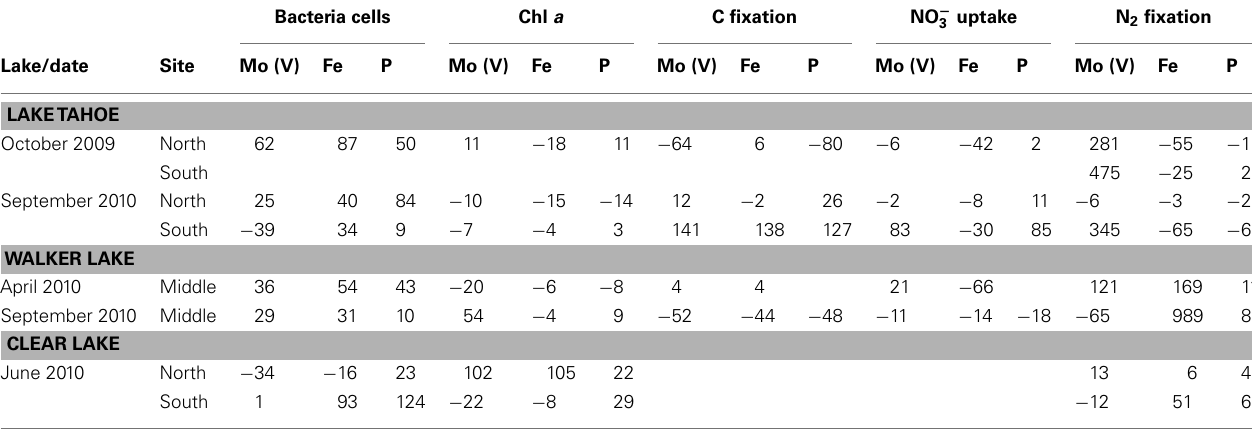
Table 3 | Normalized responses (%) of biological parameters to nutrient additions [Mo(V), Fe, P] observed in the three lakes studied at different times.